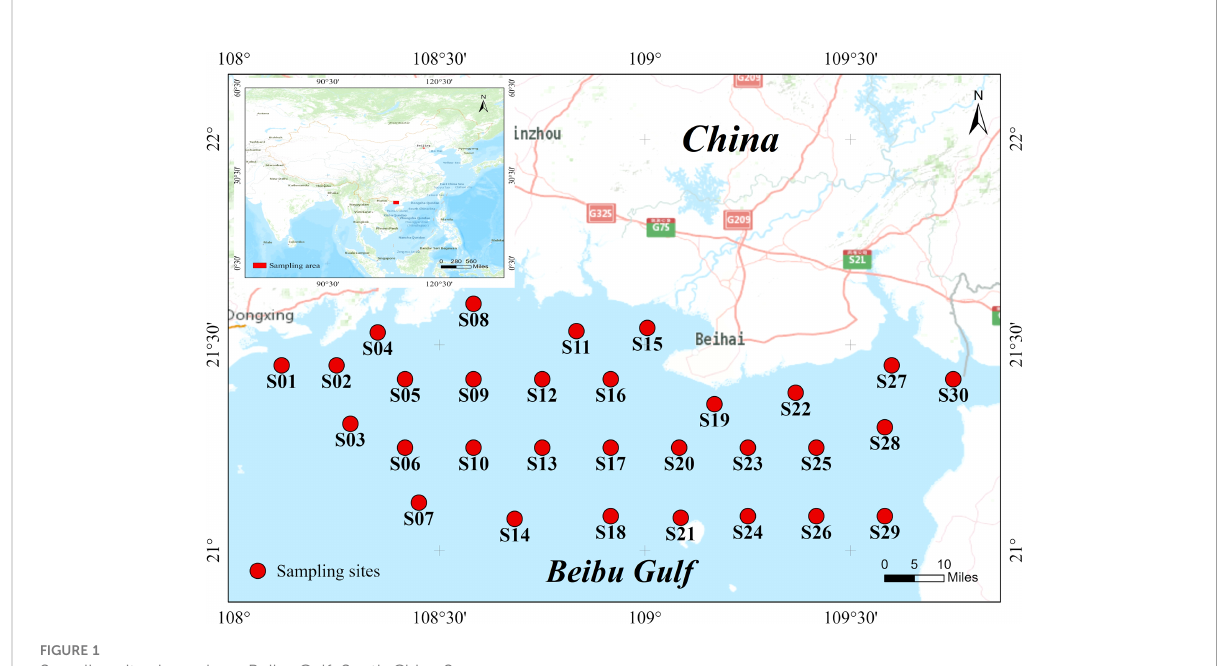
FIGURE 1 Sampling sites in onshore Beibu Gulf, South China